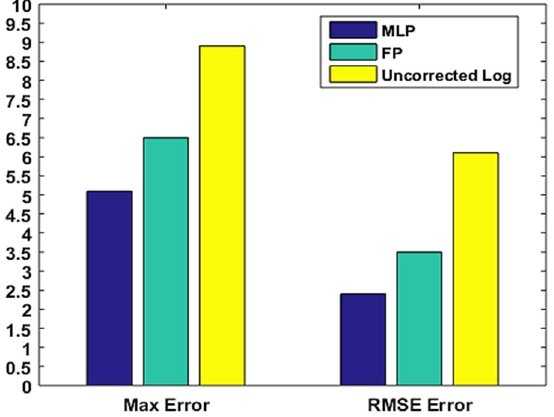
Figure 21. Comparison of the positioning maximum and RMSE error.